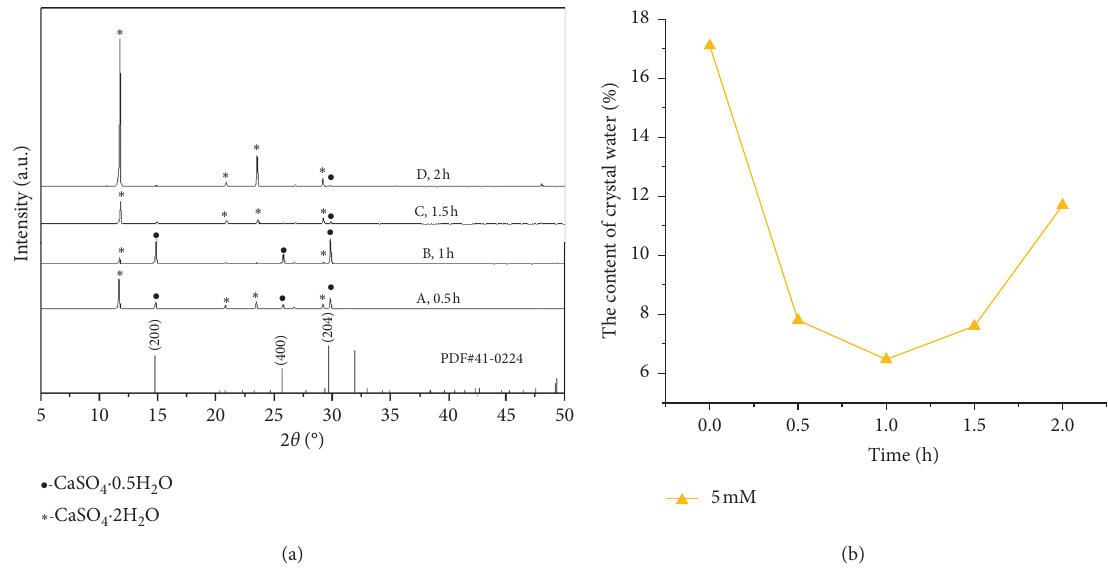
Figure 6: XRD pattern and changes in crystal water content at various reaction times (A) 0.5h; (B) 1h; (C) 1.5 h; and (D) 2 h when the aluminum ion concentration was 5 mM.